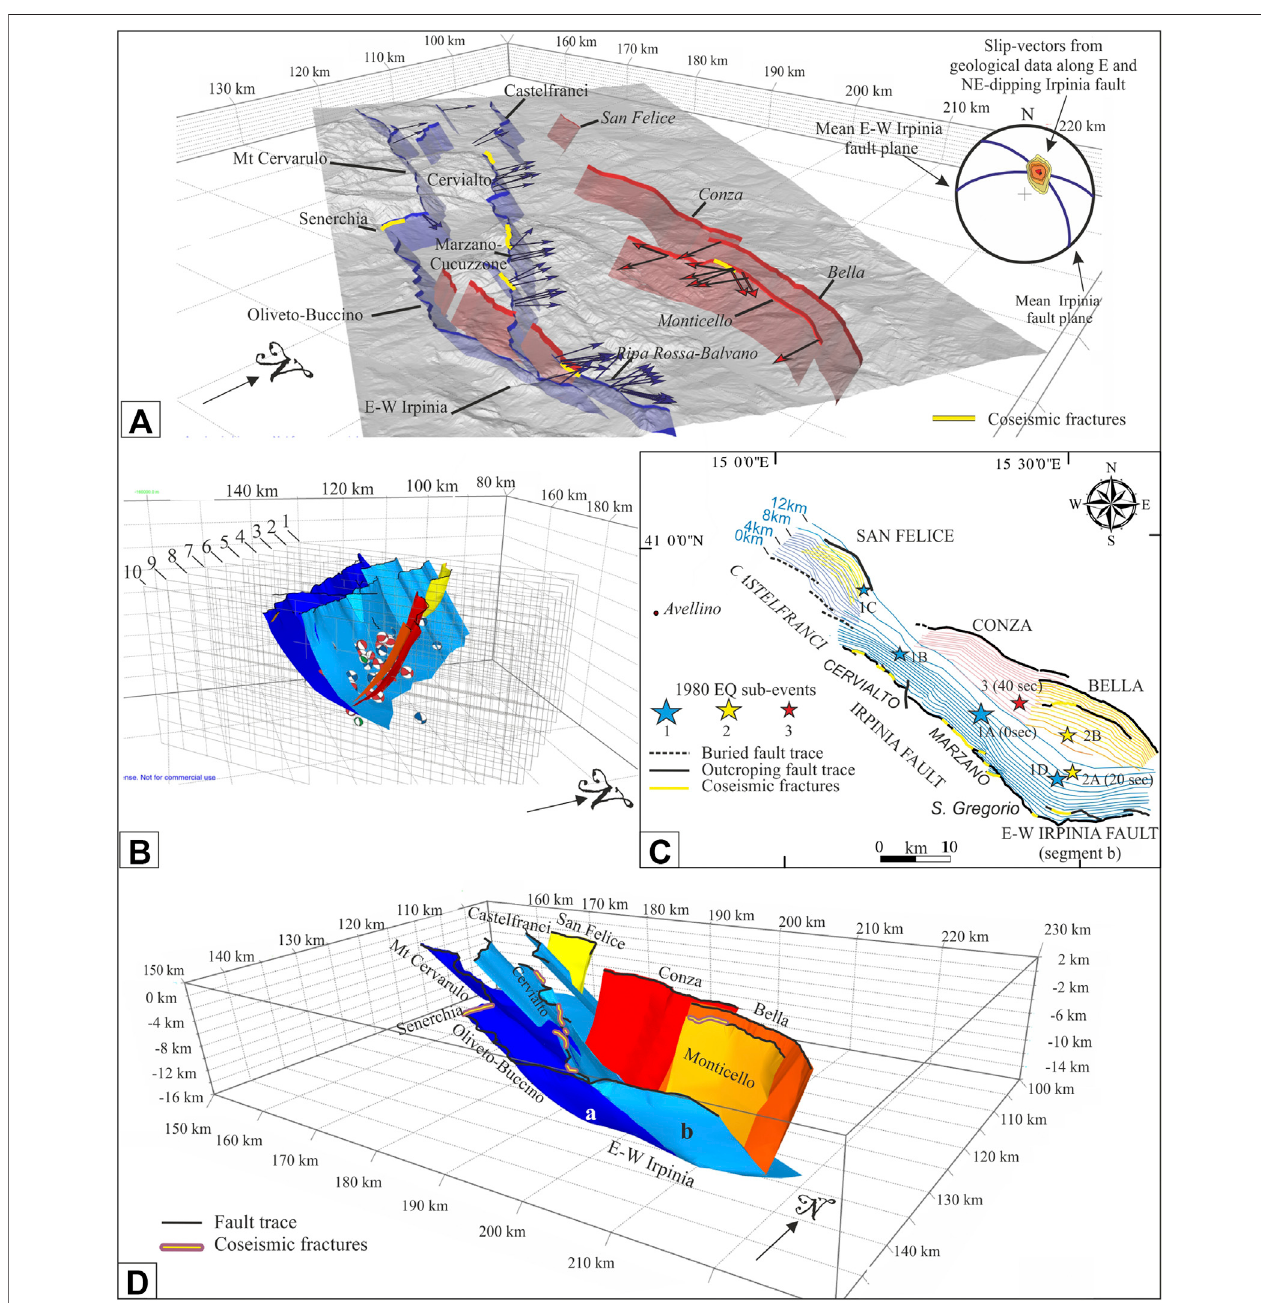
FIGURE 12 | 3D model building and seismotectonic interpretation of 1980-EQ. (A) Fault “ Ribbons ” i.e., extrapolation in depth for 3 km of the fault traces with the dip-angle acquired during the fi eld work ( Figure 3A ; Supplementary Data Sheet S2; Supplementary Tables S1, S2 ); the fault slip vectors are also reported as blue and red arrows projected on the surface. The model is represented on a 10 m DEM; the coseismic ruptures (yellow lines) are from this paper and from Pantosti and Valensise (1990). (B) Serial hypocentral and focal mechanisms cross-sections used to build the 3D surface along the ribbon down dip extrapolation (data from De Landro, et al. (2015) and De Matteis et al. (2012)). (C) Depth contour lines of the reconstructed fault surfaces with location of the epicenters of the sub-events and episodesof1980-EQ. (D) 3DfaultmodeloftheInnerIrpiniaFaultandIrpiniaFault(e.g.,Cervialto,MarzanoandSanGregorio)withtheircommonsouthernE-Wsegment plus the Antithetic Fault